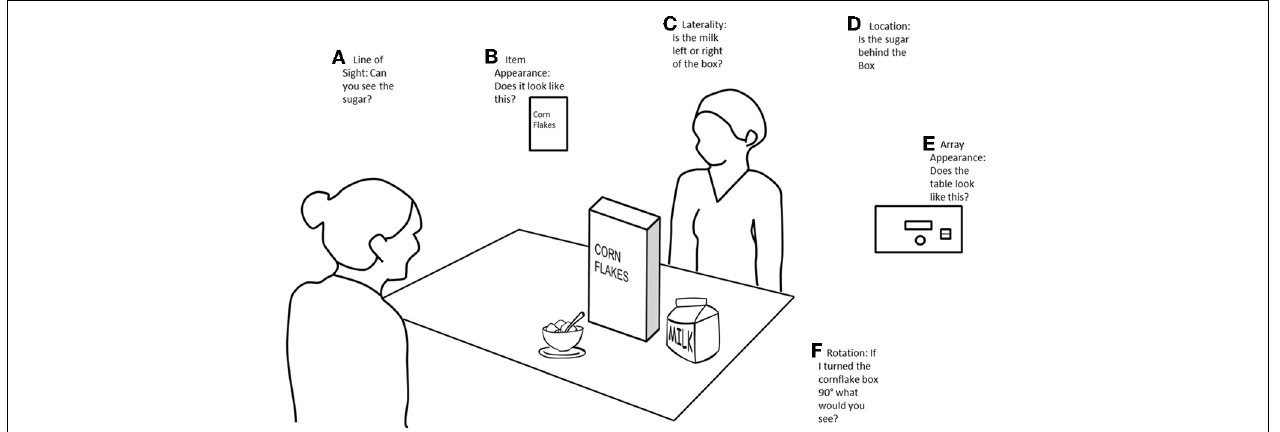
FIGURE 1 | Example of different ways in which VPT can be examined. (A) Line of sight paradigms ask questions about whether a person can see an item, for example, “can the person on the far side of the table see the sugar bowl?” (B) Item appearance paradigms ask questions about how an item would appear from different points of view, for instance, “would the person on the far side of the table see the front of the cereal box?” (C) Laterality paradigms ask questions about the position of certain items, for instance, “is the milk to the left or right hand side of the cereal box?” (D) Item location